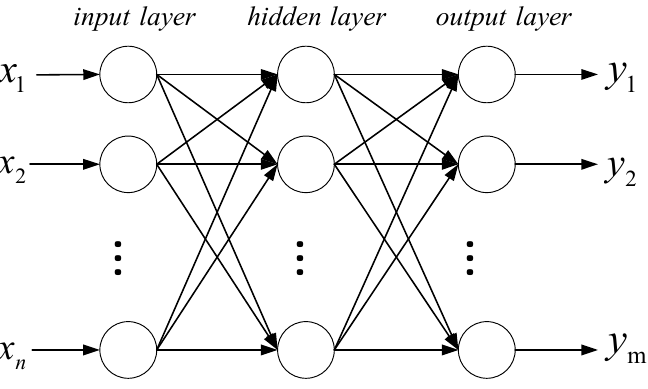
Figure 6. Program flow diagram of the model.